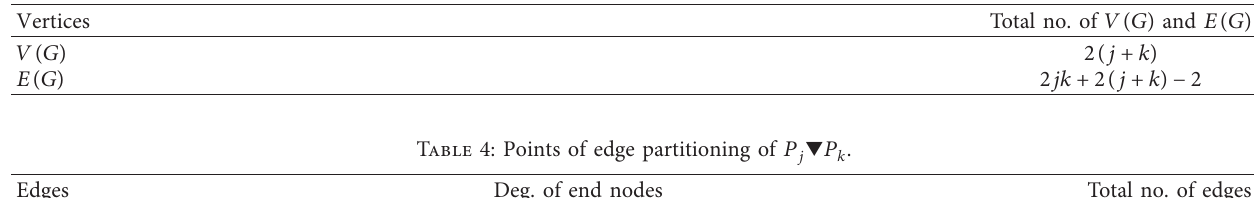
Figure 4: Indu-Bala graph P